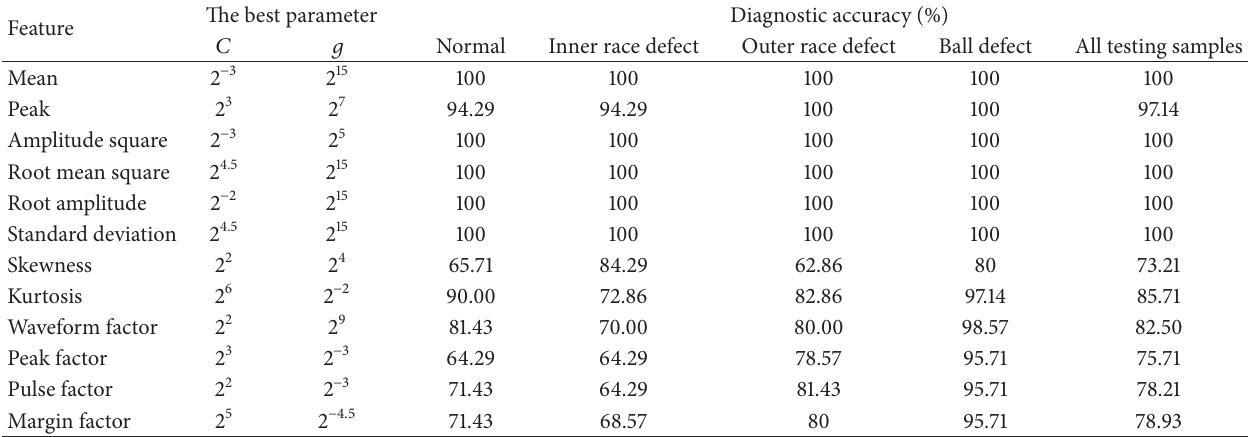
Table 4: Diagnostic results of rolling bearing by using different features for fusion.